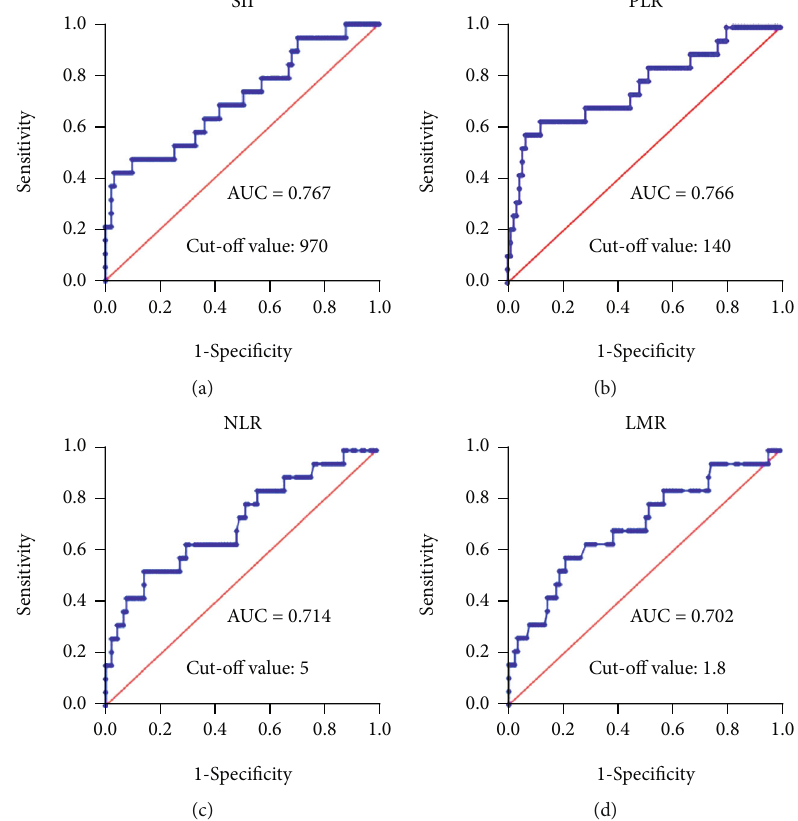
Figure 1: Receiver operating characteristic curves were generated to evaluate the discriminatory ability of the systemic immune-in fl ammation index, platelet-to-lymphocyte ratio, neutrophil-to-lymphocyte ratio, and lymphocyte-to-monocyte ratio. SII: systemic immune-in fl ammation index; PLR: platelet-to-lymphocyte ratio; NLR: neutrophil-to-lymphocyte ratio; LMR: lymphocyte-to-monocyte